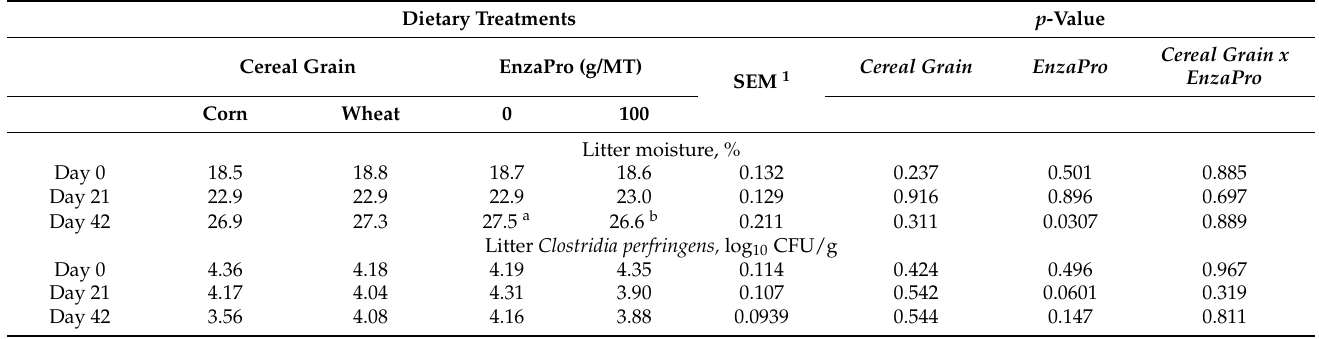
Table 4. Least-square means for litter moisture and environmental pathogen load indicators.